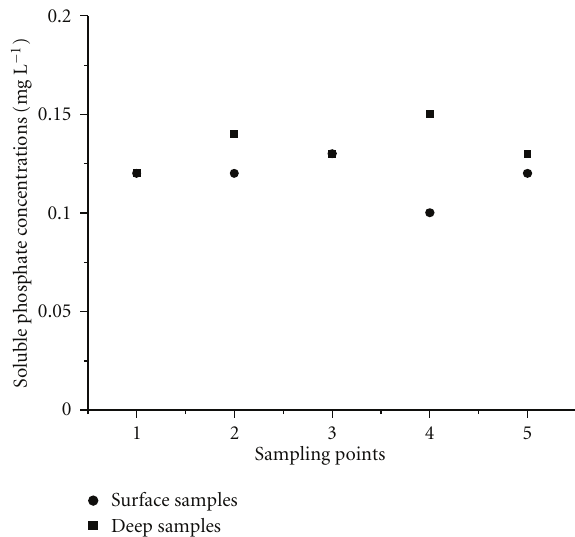
Figure 4: Electrical conductivity in water samples collected in July of 2007.